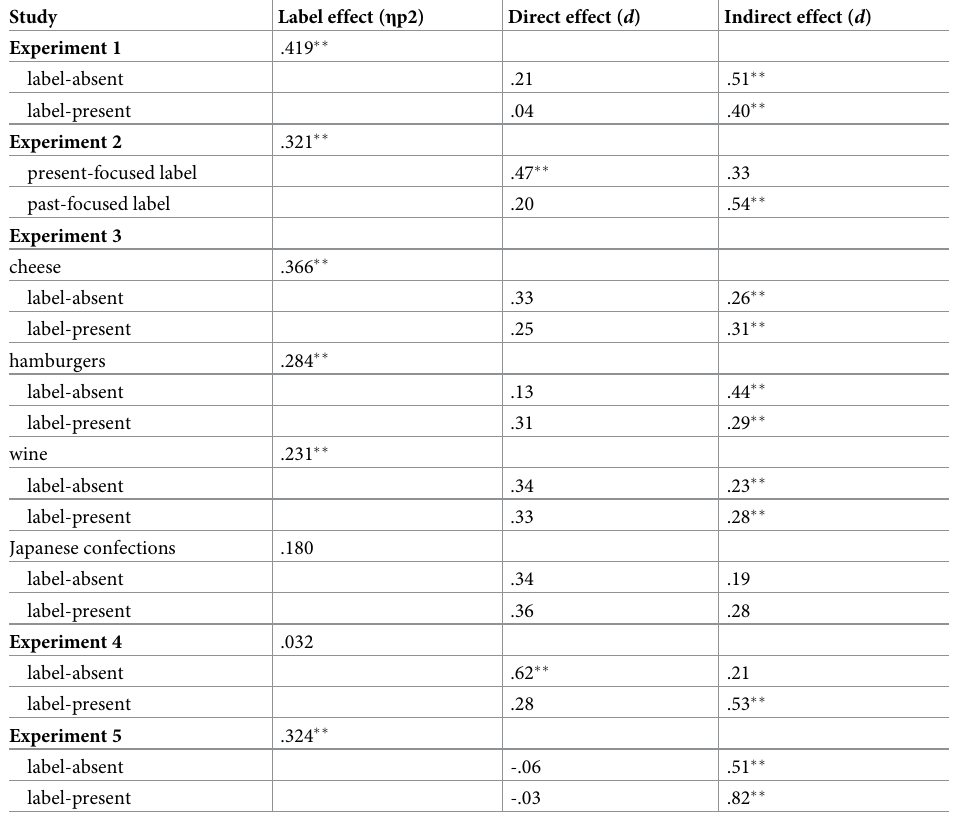
Table 2. Summary of the MANOVA and mediation analysis